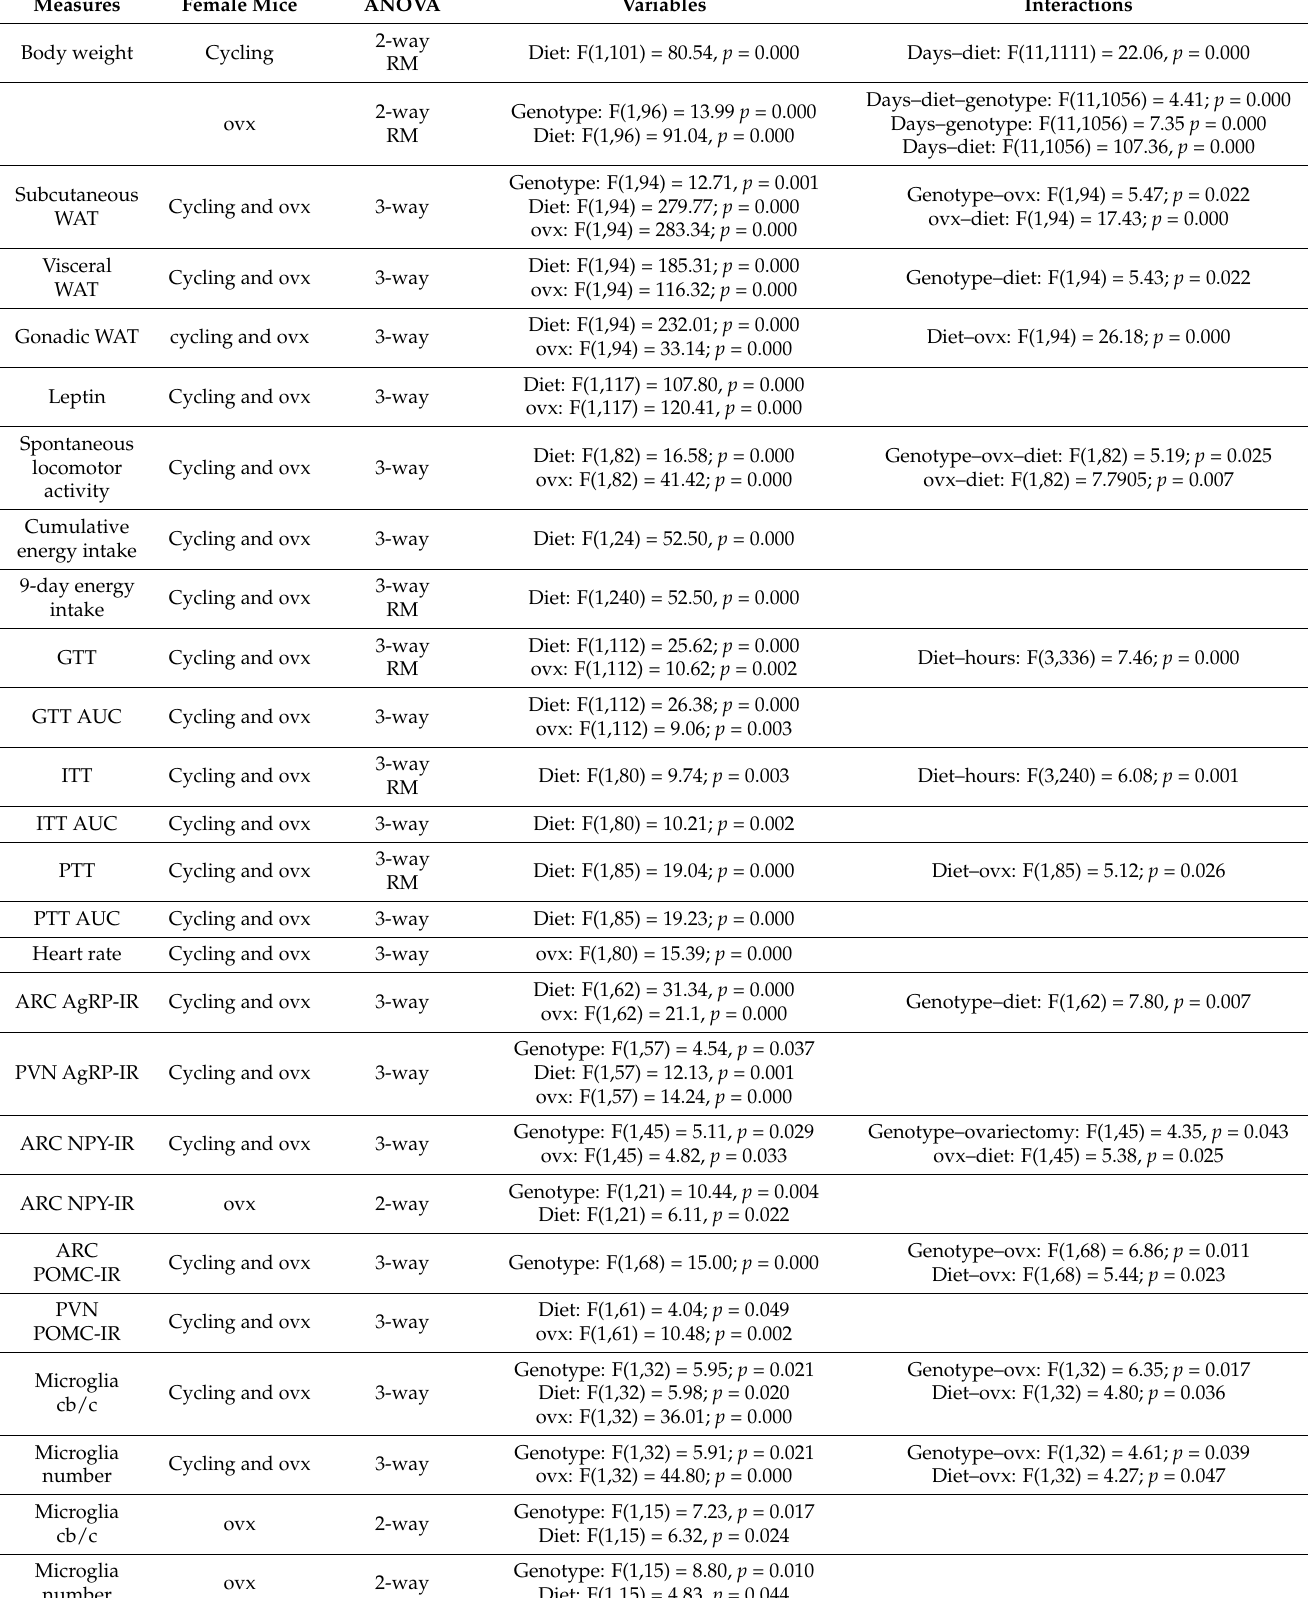
Table 1. Statistical